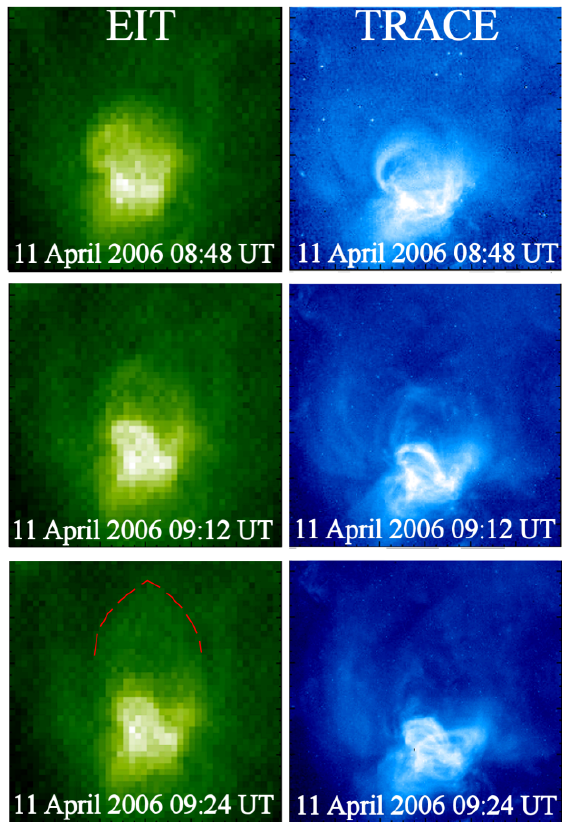
Fig. 6. Coronal evolution of the small, Northern Hemisphere active region prior to and following the eruption that occured in this re- gion at ∼ 09:24UT on 11 April 2006. The left column shows data from SOHO/EIT at 195 ˚A. A cusp-shaped coronal loop is oberved at 09:24UT (red dashed line) providing evidence of an eruption in this region. The right column shows data from TRACE at 171 ˚A, in which post-eruption loops are observed coinciding with the time of the eruption estimated from the SOHO/EIT observations. The field of view of these images is 120 × 120arcsec (2.62arcsec per